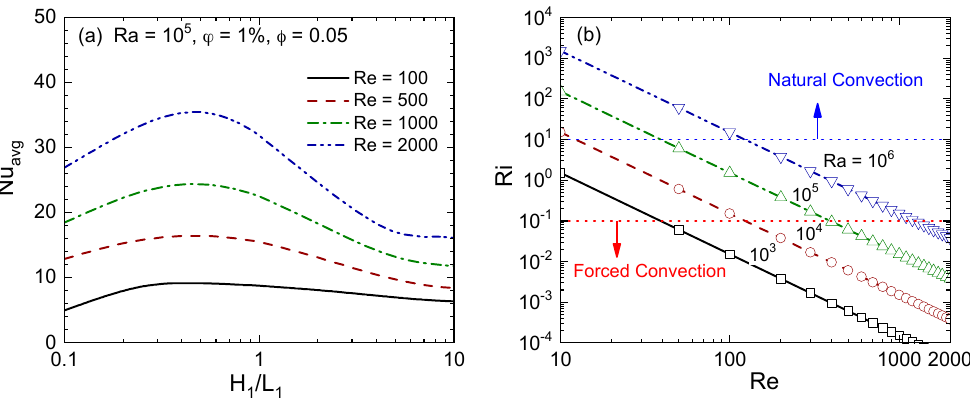
Figure 13. ( a ) Effect of fin aspect ratio ( H 1 / L 1 ) on the average Nusselt number (Nu avg ) for various Reynolds numbers and ( b ) Richardson number as a function of Reynolds number for various Rayleigh numbers for 1% Al 2 O 3 –water nanofluid. The variations of Nu avg are depicted for ϕ = 1% and φ = 0.05. Different line types correspond to different Reynolds or Rayleigh numbers as indicated in the legend. Reproduced from Ref. [39], with the permission of AIP Publishing.